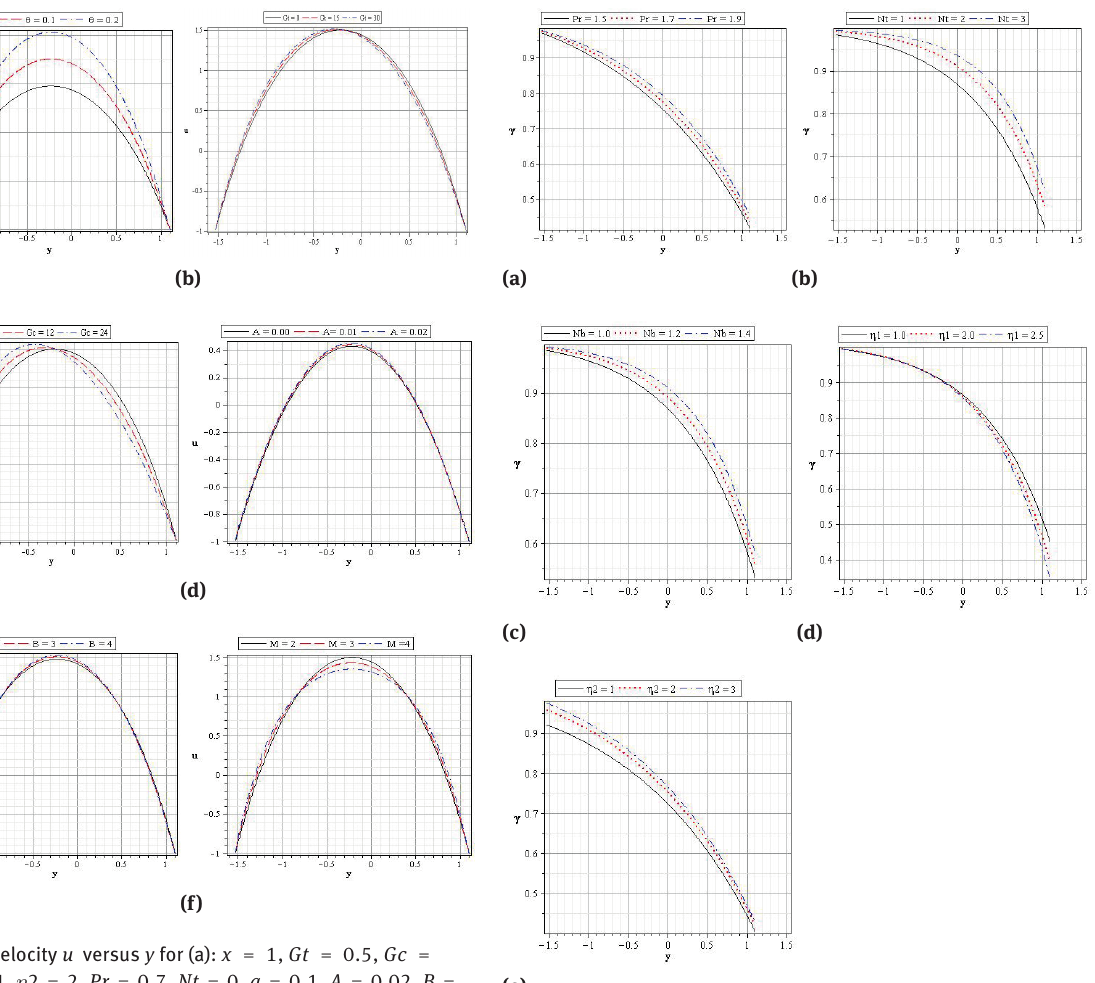
Fig. 3: Temperature profiles γ versus y for (a): x = 1, Gt =